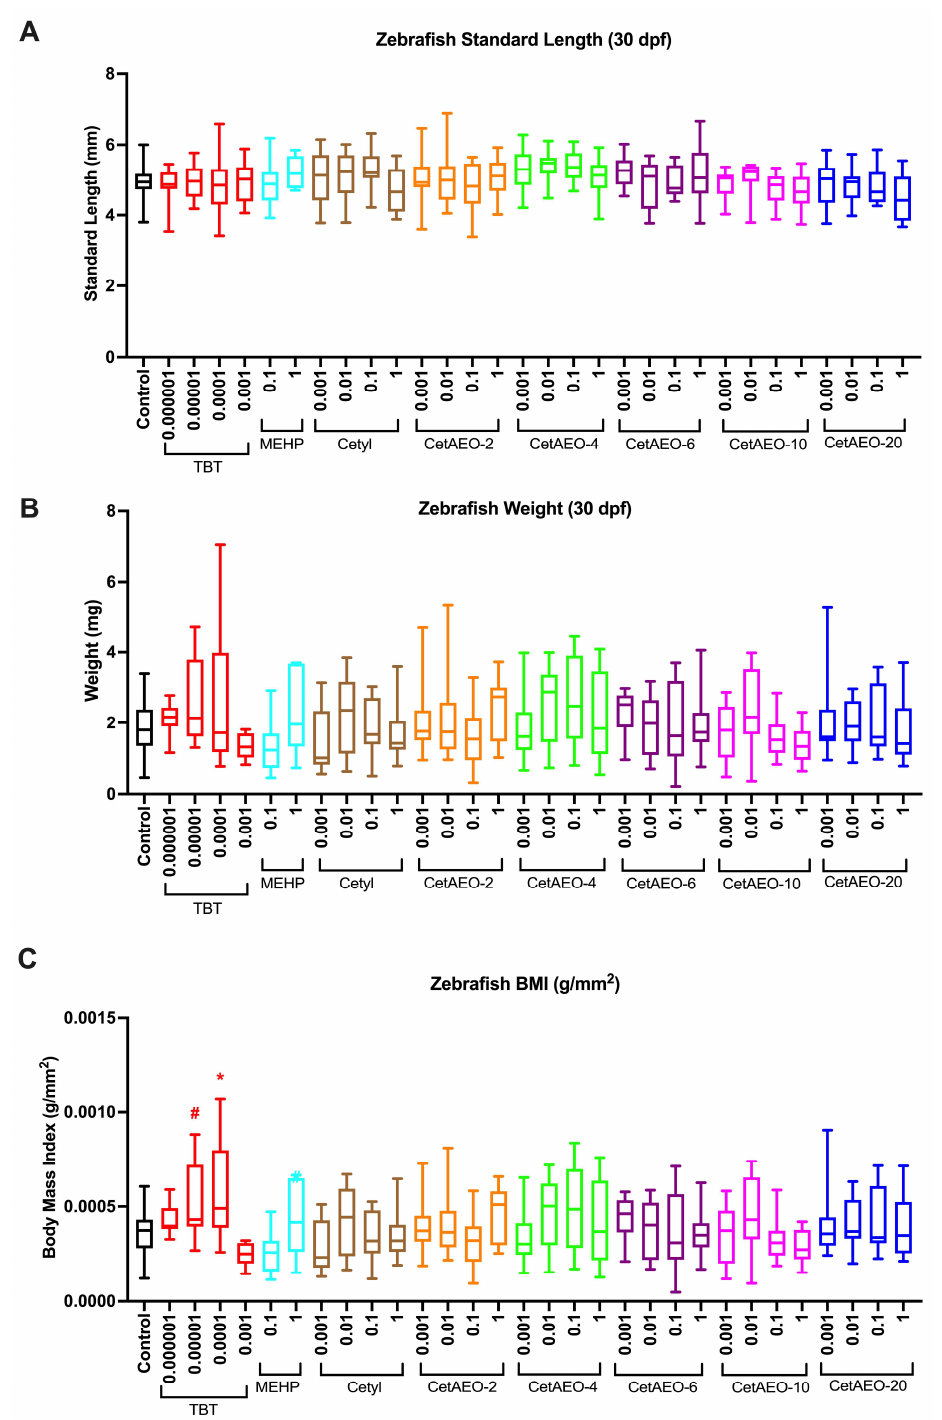
Figure 5. Growth Trajectories in Zebrafish Developmentally Exposed to Cetyl Alcohol and Polyethoxylates. Zebrafish were developmentally exposed to control chemicals, cetyl alcohol, or cetyl alcohol polyethoxylates; aged to 30 days post fertilization; then measured and stained with Nile Red according to Methods. Zebrafish were imaged, and the standard length of each fish was measured ( A ) using the integrated point−to−point measurement tool within the Leica software, which scales by magnification. Following imaging, zebrafish were blotted with Kimwipes and weighed on a mi- crobalance to obtain total body weights ( B ) for each fish and then averaged across test chemicals and concentrations. Zebrafish body mass index or Fulton’s condition factor ( C ) was calculated by dividing the calculated standard length and weights and correcting measurement units to g/mm 2 . DMSO−exposed fish and embryo media fish were not significantly different and are thus included as one control reference group. N = 31 (controls), 14, 14, 15, 11, 17, 6, 13, 16, 15, 20, 14, 16, 17, 13, 17, 13, 11, 15, 11, 15, 11, 17, 11, 13, 15, 13, 15, 12, 12, and 11 across four spawning events (biological